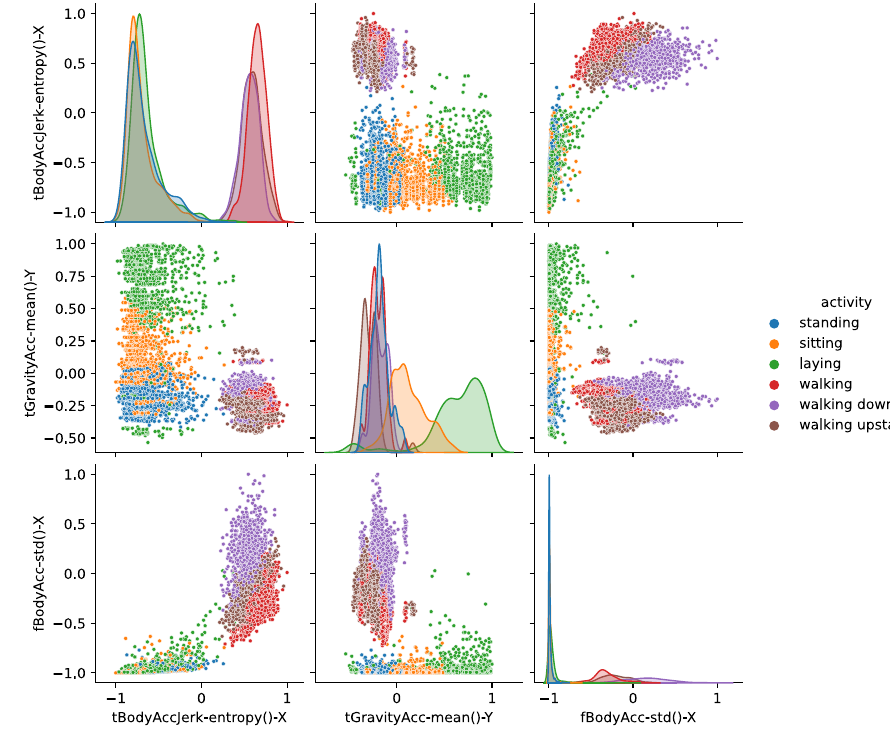
Figure 2. Feature pair plot for a few selected